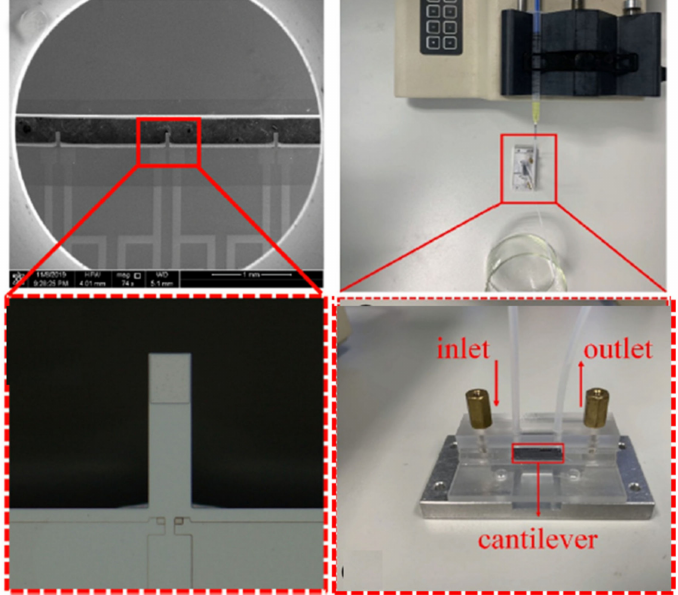
Figure 6. Enlarged view of the biosensor fabricated through the cantilever method and the process flow adopted for the manufacturing of the biosensor (reprinted with permission from Ref. no. [91], copyright 2021,